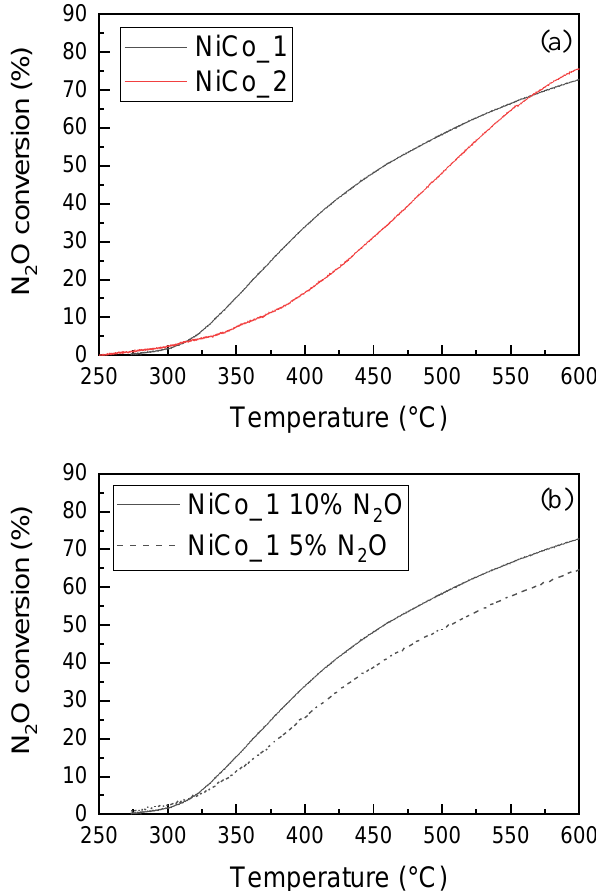
Figure 10. Catalytic performances of NiCo samples. Operating conditions: GHSV = 15,000 h − 1 , 1 atm, ( a ) N 2 O and O 2 10 vol% in Ar; ( b ) N 2 O and O 2 5 vol% and 10 vol% in Ar, GHSV = 15,000 h – 1 .